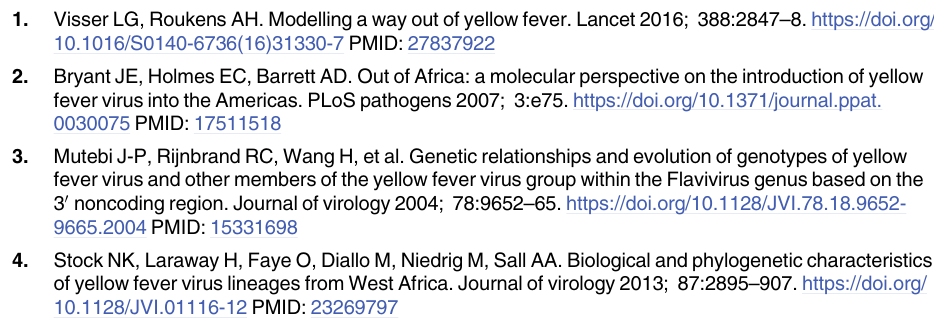
S5 Table. Two primer sets used for amplicon-sequencing. S6 Table. SNPs observed in